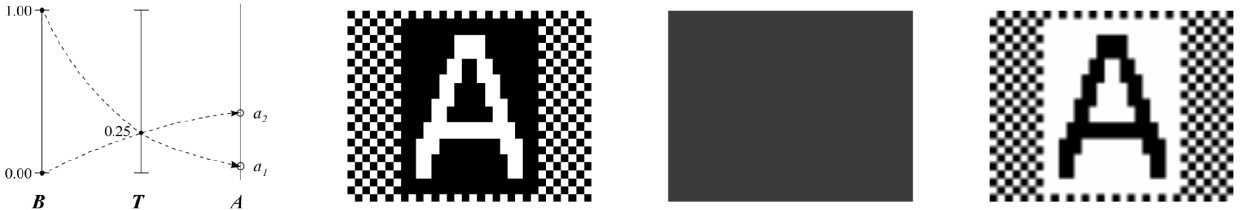
Figure 4. Trigger ambiguity. Left: diagram of rule set f 1 , with arrows linking the bias and trigger intensities that are used to their target afterimage intensities. Middle, left: the bias image from an image sequence generated by rule set f 1 . Middle, right: the evenly grey trigger image. Right: the target afterimage pattern, with a 1 shown as black, and a 2 shown as white.